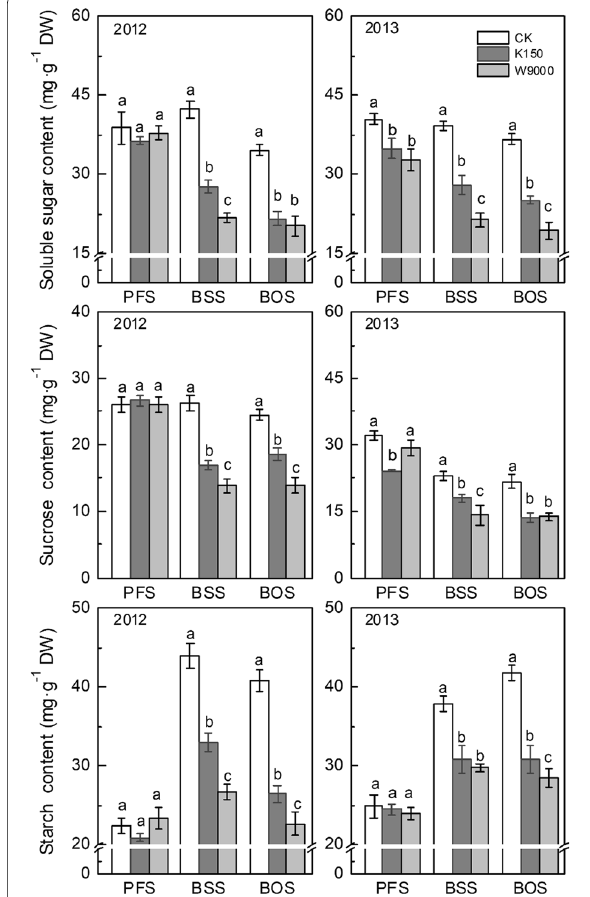
Fig. 3 Effects of straw-returning and inorganic K fertilizer on soluble sugar, sucrose and starch contents in the functional leaf at the peak flowering (PFS), boll-setting (BSS) and boll-opening (BOS) stages of Siza 3 in 2012 and 2013. The data are means of three replications standard error. For each growth stage, bars bearing ± different letters are significantly different at P =